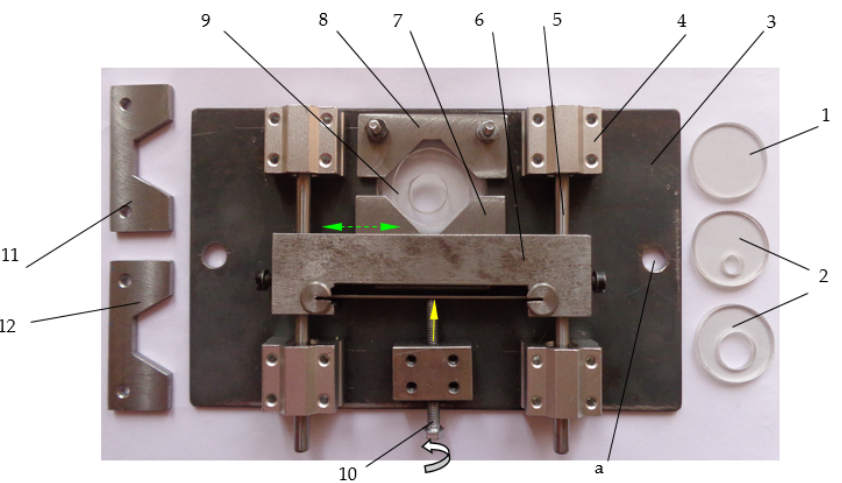
Figure 9. Experimental device constructed for loading of photoelastic probes: (1) compact disk; (2) eccentric ring; (3) base plate; (4) ball linear rolling guides; (5) shaft; (6) transversal part; (7,8) prismatic parts; (9) photoelastic ring; (10) screw; (11,12) prismatic parts with changed angle.